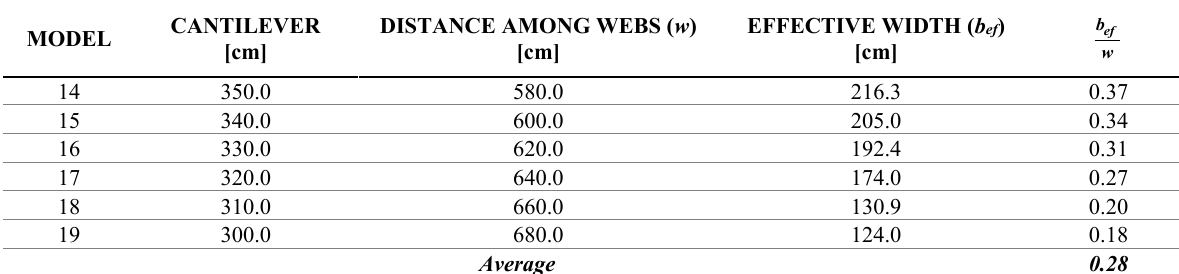
Table 6. Relationship between the effective numerical width and the distance between webs for the simple box con figuration. MODEL